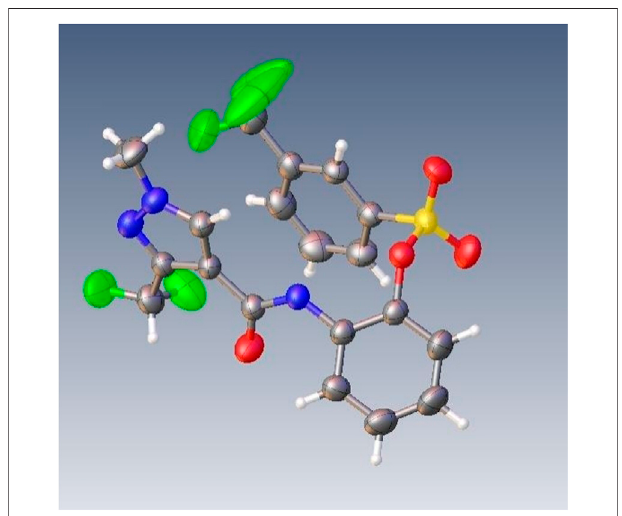
FIGURE 1 | The single-crystal X-ray diffraction of compound T22.